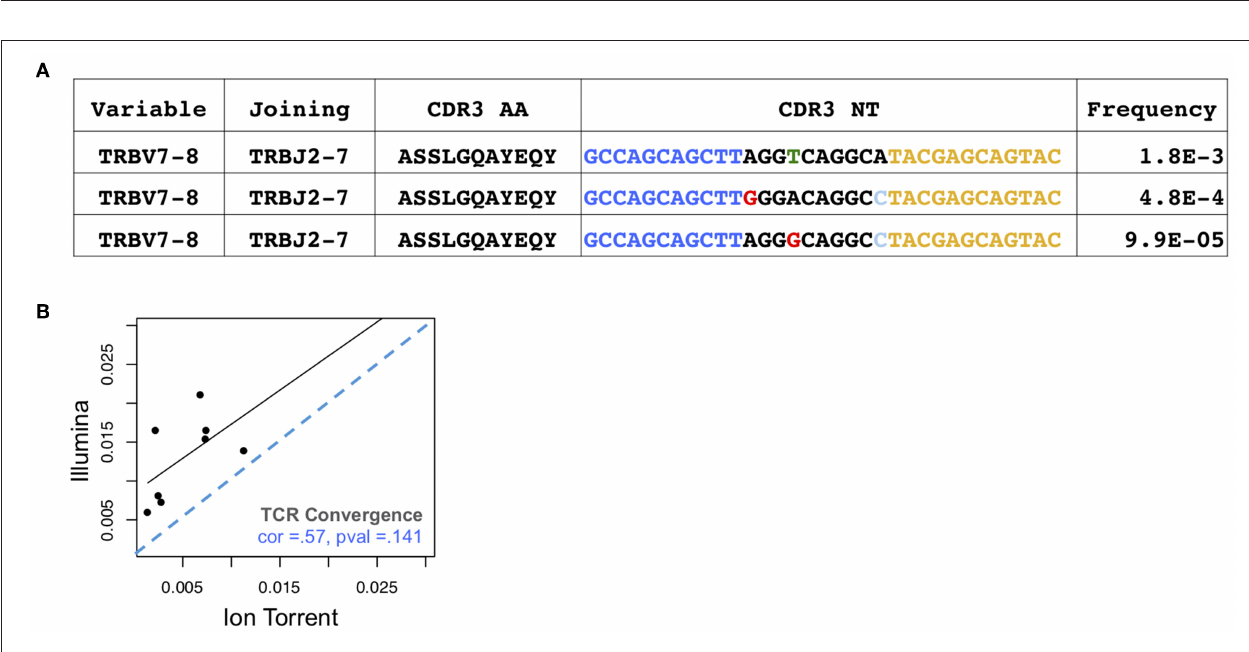
FIGURE 2 | Assessment of TCR convergence. (A) Example of a convergent TCR group detected in the peripheral blood of an individual with melanoma. This group consists of three TCR β clones that are identical in TCR β amino acid space but have distinct CDR3 NT junctions owing to differences in non-templated bases at the V-D-J junction. Blue indicates bases contributed by the variable gene while yellow indicates bases contributed by the joining gene. Red arrows indicate positions where clones differ. Substitution sequencing errors and PCR errors can create artifacts that resemble convergent TCRs. (B) TCR convergence, calculated as the aggregate frequency of clones sharing an amino acid sequence with at least one other clone. Blue dashes indicate position of identity